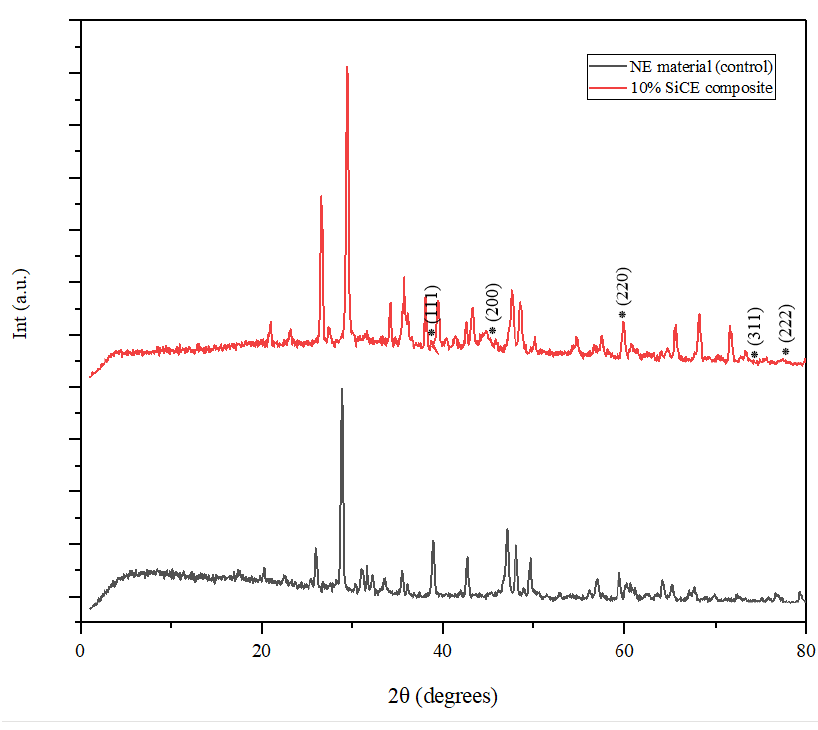
Figure 7. XRD diffractogram of the processed control and the 10%SiCE composite samples.